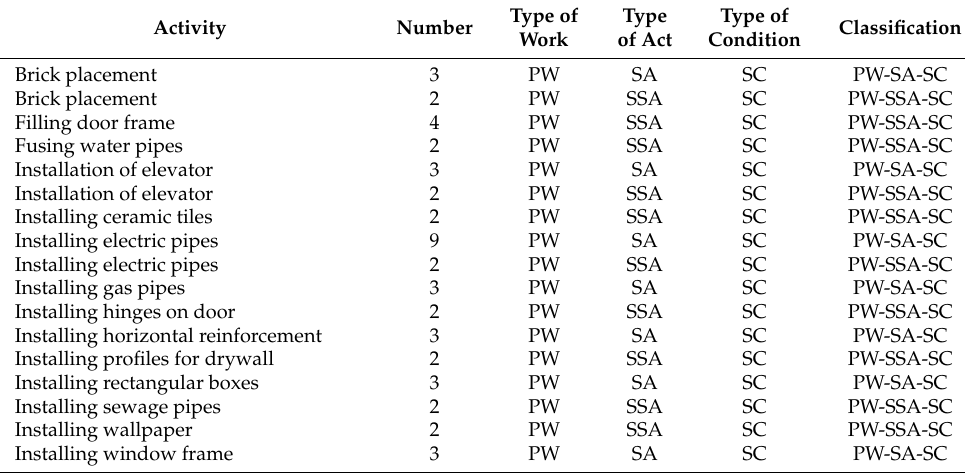
Table 5. Work Sampling based on the new